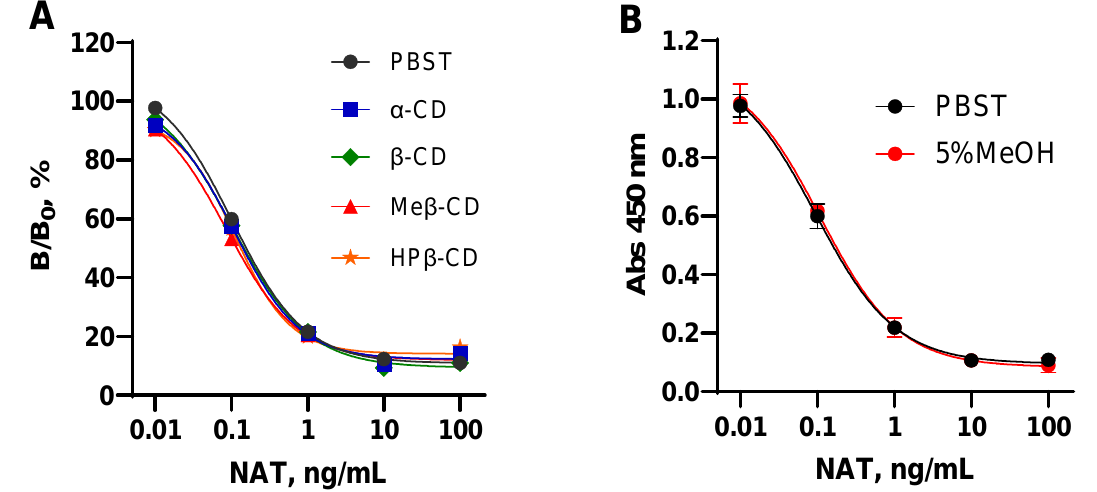
Figure 4. Effect of cyclodextrins ( A ) and methanol ( B ) on NAT standard curves in the developed ELISA. NAT standard curves were generated in CD solutions (10 µg/mL). Each point is presented by average ( n = 4). The error bars correspond to the standard deviation.